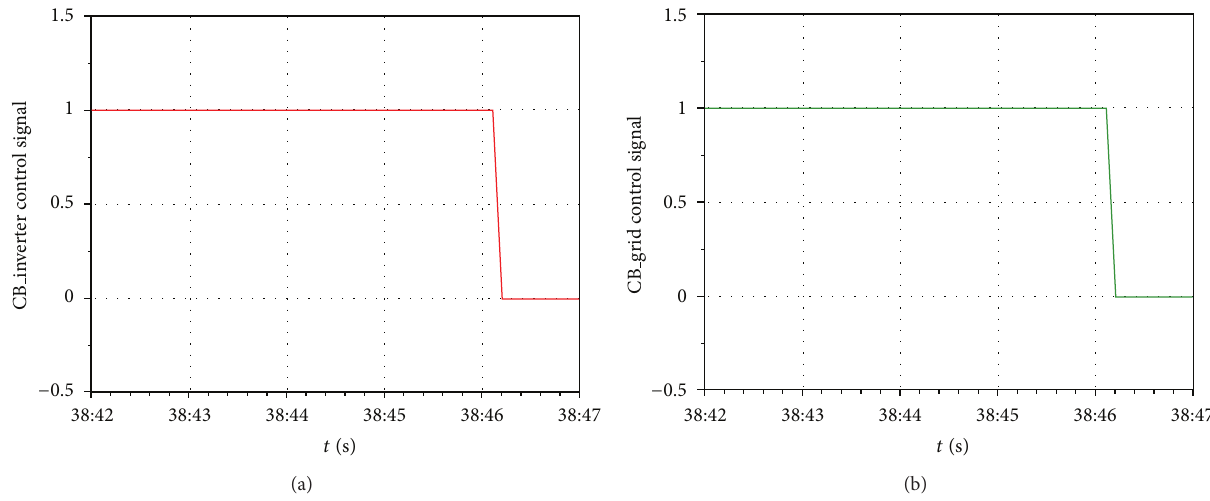
Figure 25: Control signals of circuit breakers for over voltage